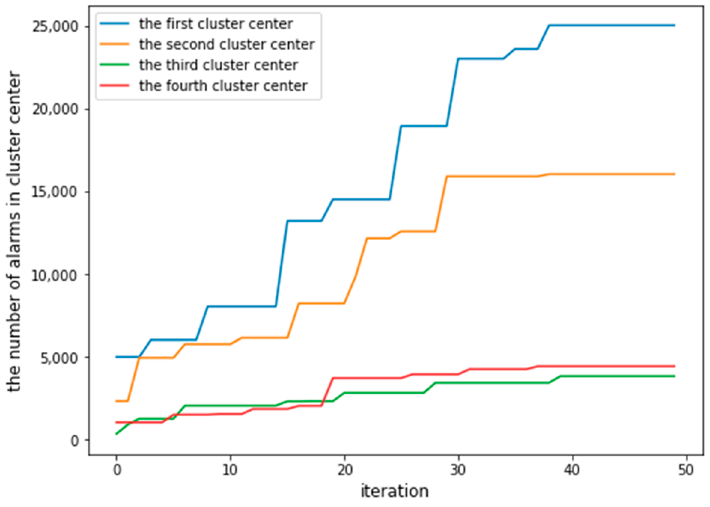
Figure 15. Alarm clustering result of 4 consecutive calls to WOAHC-L.